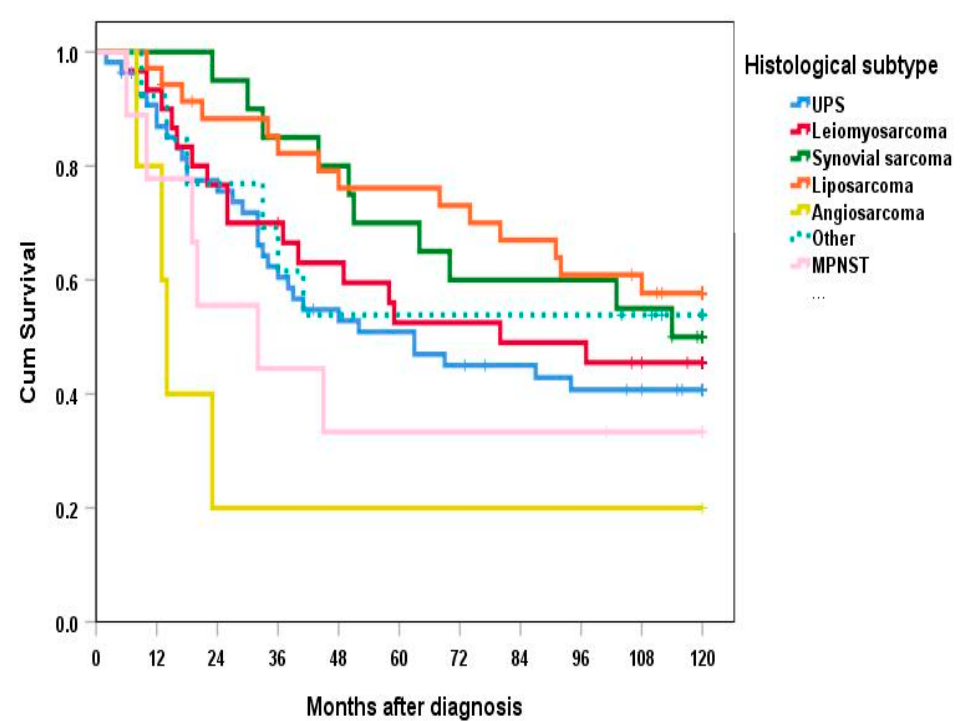
Figure 2. Overall survival according to histological subtype. UPS—undifferentiated pleomorphic sarcoma. MPNST—malignant peripheral nerve sheath tumor. Other—3 Chondrosarcomas, 4 Myxofibrosarcomas, 1 Alveolar sarcoma, 2 Carcinosarcomas, 1 Rhabdomyosarcoma, 2 malignant solitary fibrous tumors.